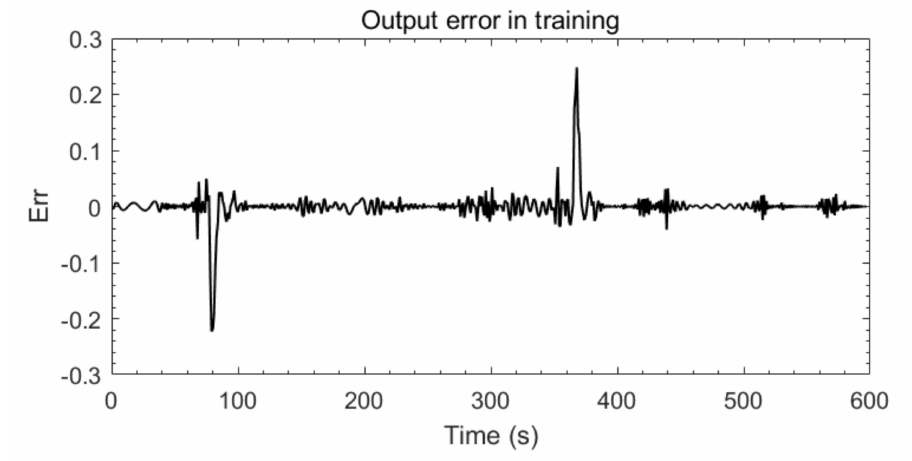
Figure 13. Output error in training.